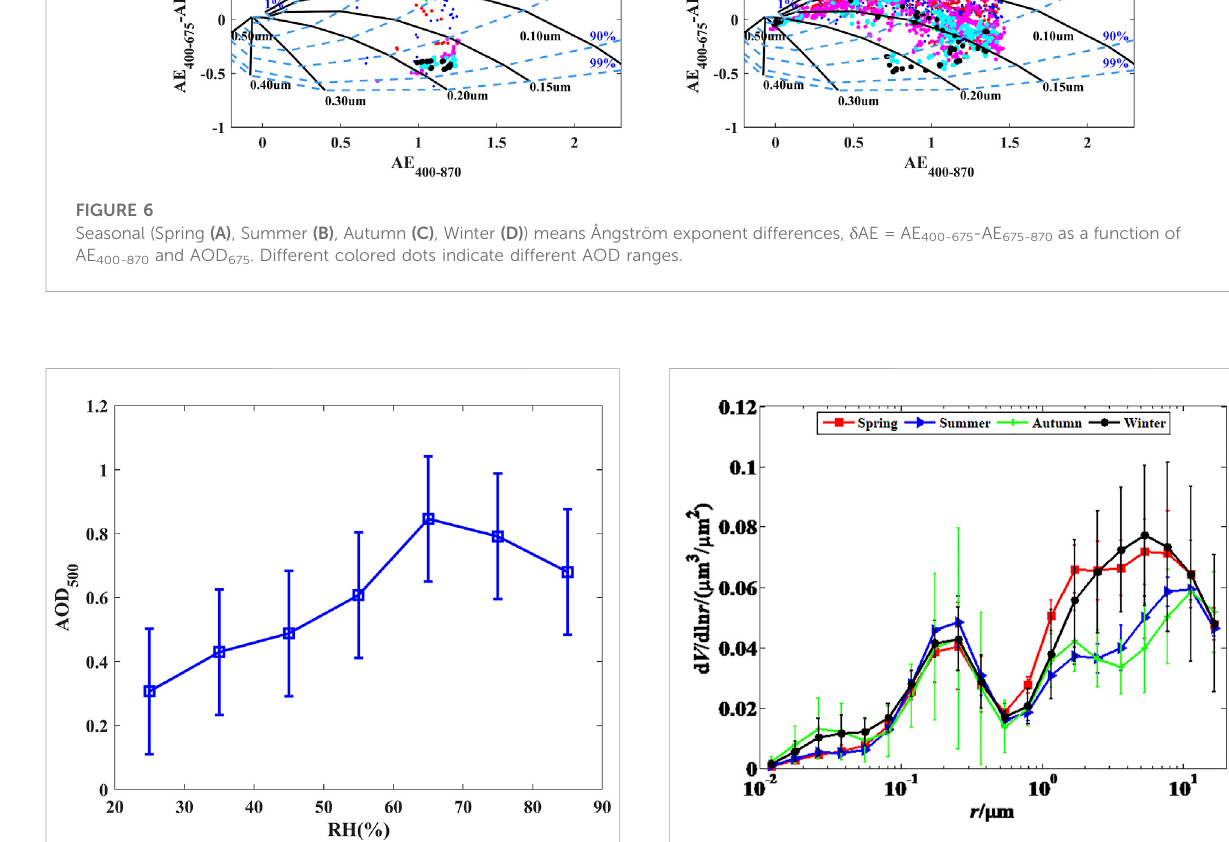
FIGURE 7 The relationship of AOD and relative humidity from 2015 to 2018. AOD are averaged for seven relative humidity bins ranging from20%to90%,andtheverticallinesindicatestandarddeviation.